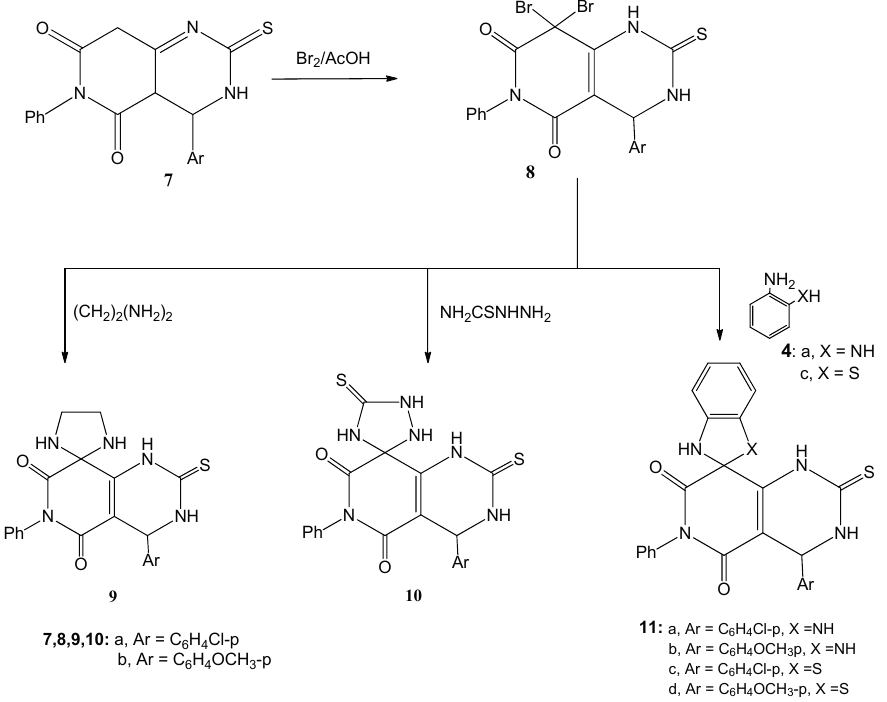
Scheme 2. Reaction of dibromopyridopyrimidines 8a , b with binucleophilic reagents; formation of 9 , 10 and 11 .